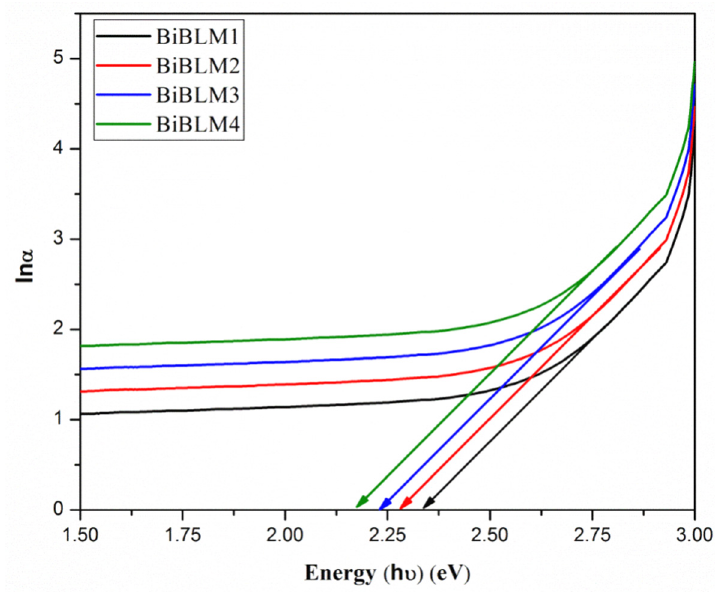
Figure 8. Urbach energy of BiBLM glasses.